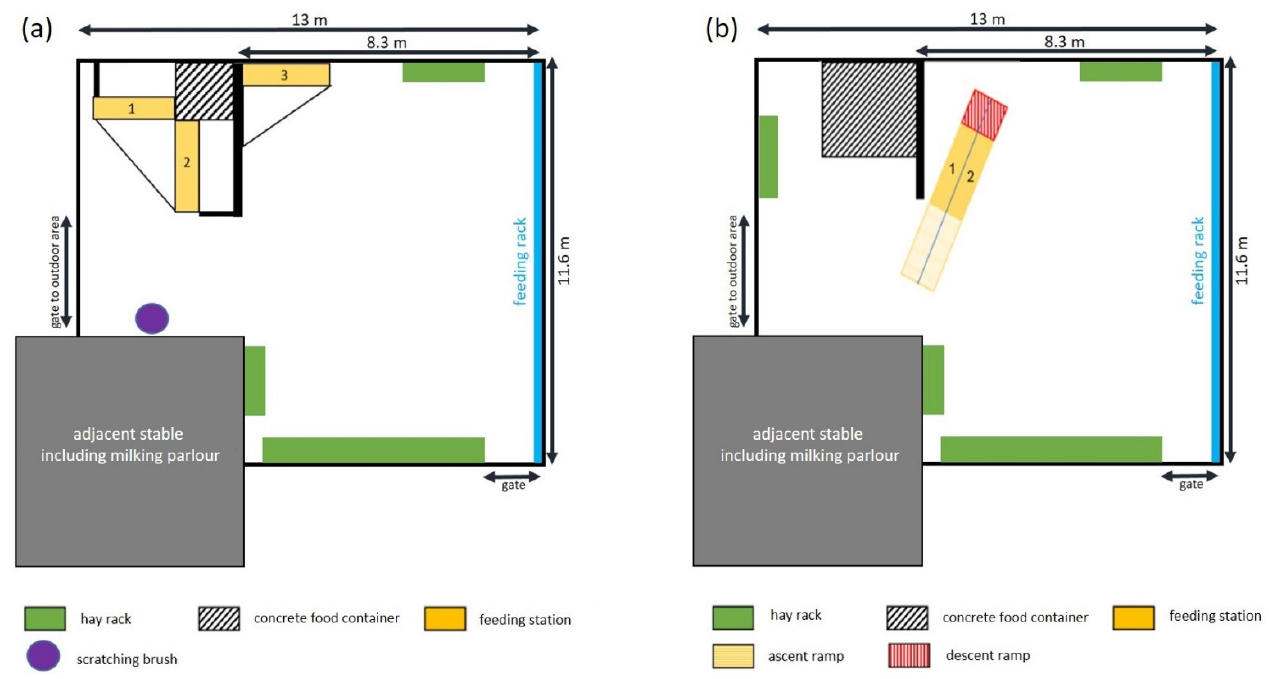
Figure 1. Schematic representation of the stable before ( a ) and after ( b ) installation of the new automatic feeding system in bird’s eye view. (Numbers 1, 2 (and 3) show the different feeding stations. “m” = meters). Goats were milked twice a day in a milking parlour, starting between 7:30